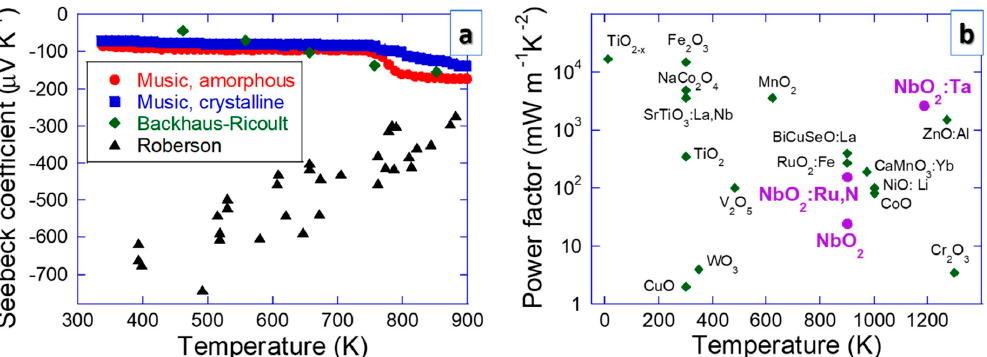
Figure 5. The electrical properties, including ( a ) the Seebeck coefficient (Music et al. [13], Backhaus-Ricoult et al. [14], Roberson et al. [15]) and ( b ) power factor data, for NbO 2 compared with other oxide systems [67–84]. The power factor is a product of the squared Seebeck coefficient and electrical